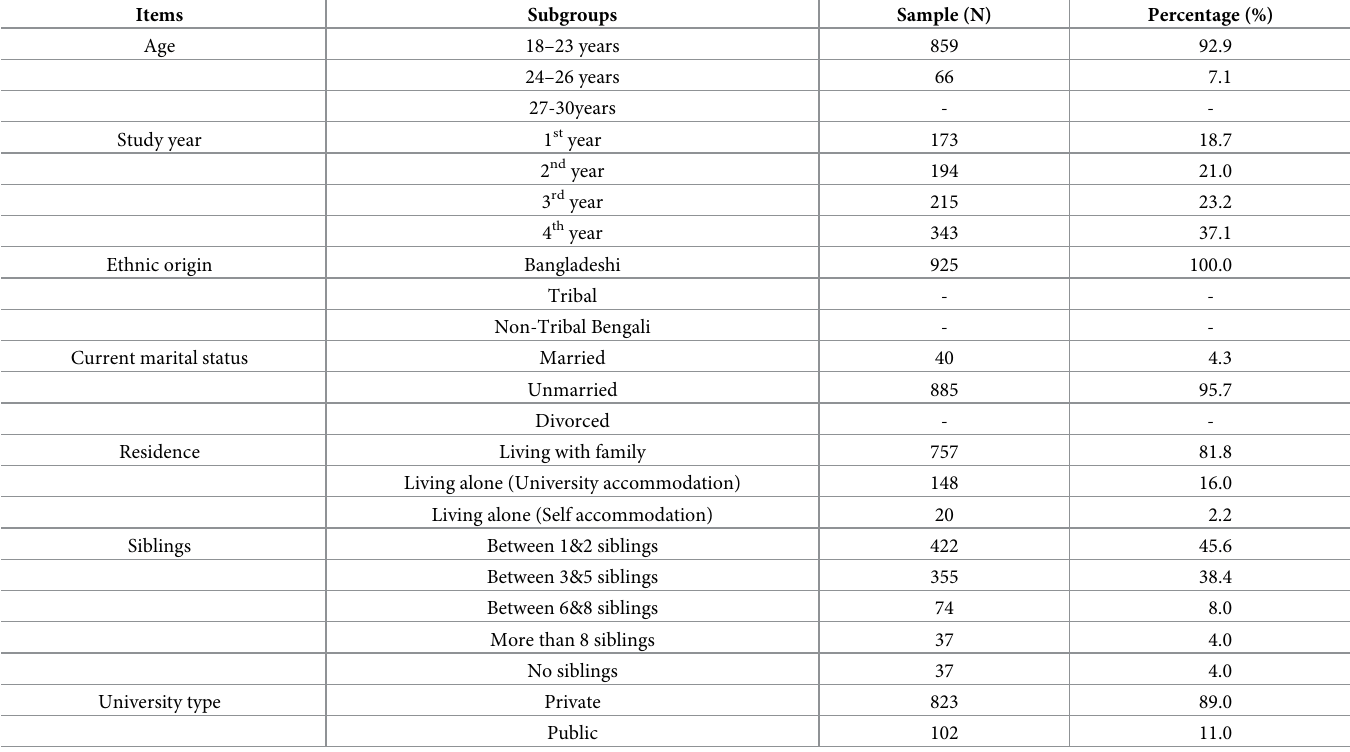
Table 1. Demographic information of the